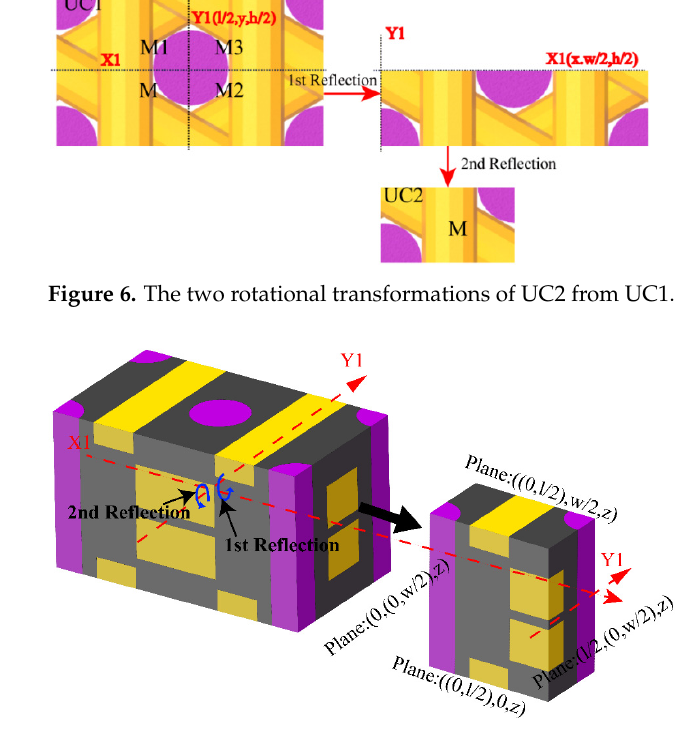
Figure 7. UC1 and UC2 model of four-directional carbon/carbon (4D C/C) composites.